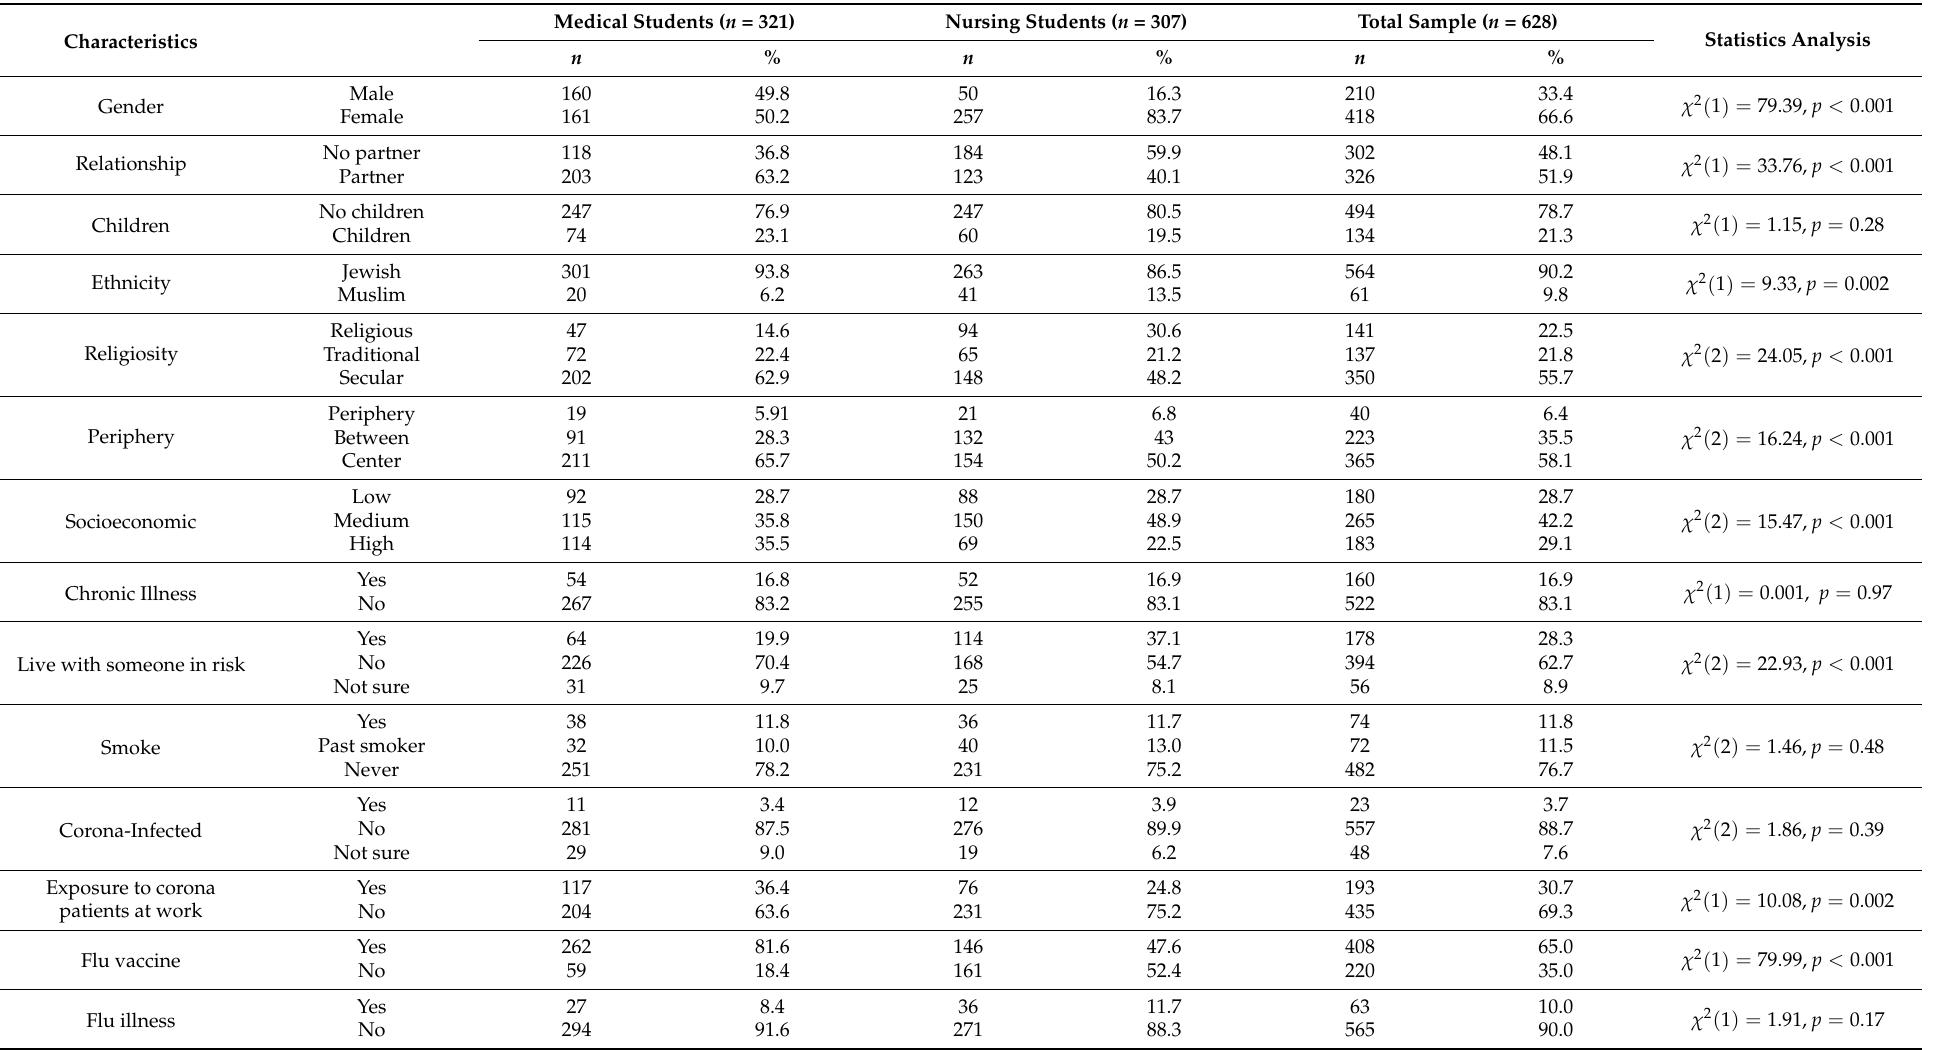
Table 1. Comparison of baseline characteristics between medical students and nursing students, using chi-squared tests ( n =